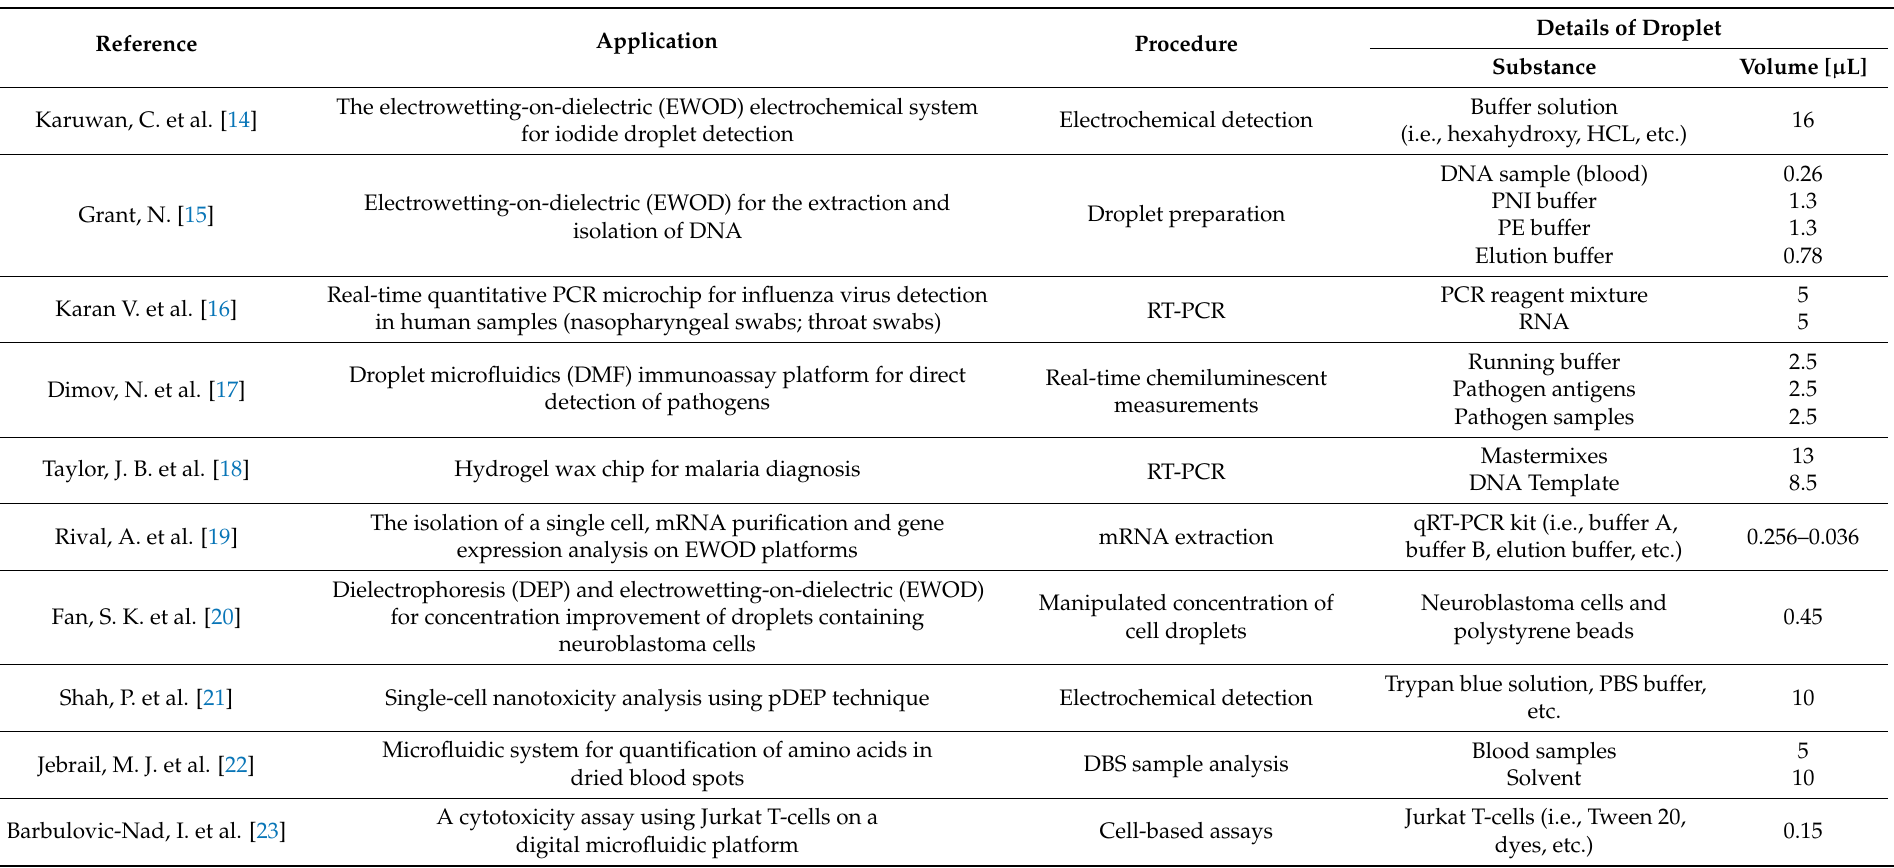
Table 2. Examples of lab-on-a-chip (LOC) applications and reactant droplet